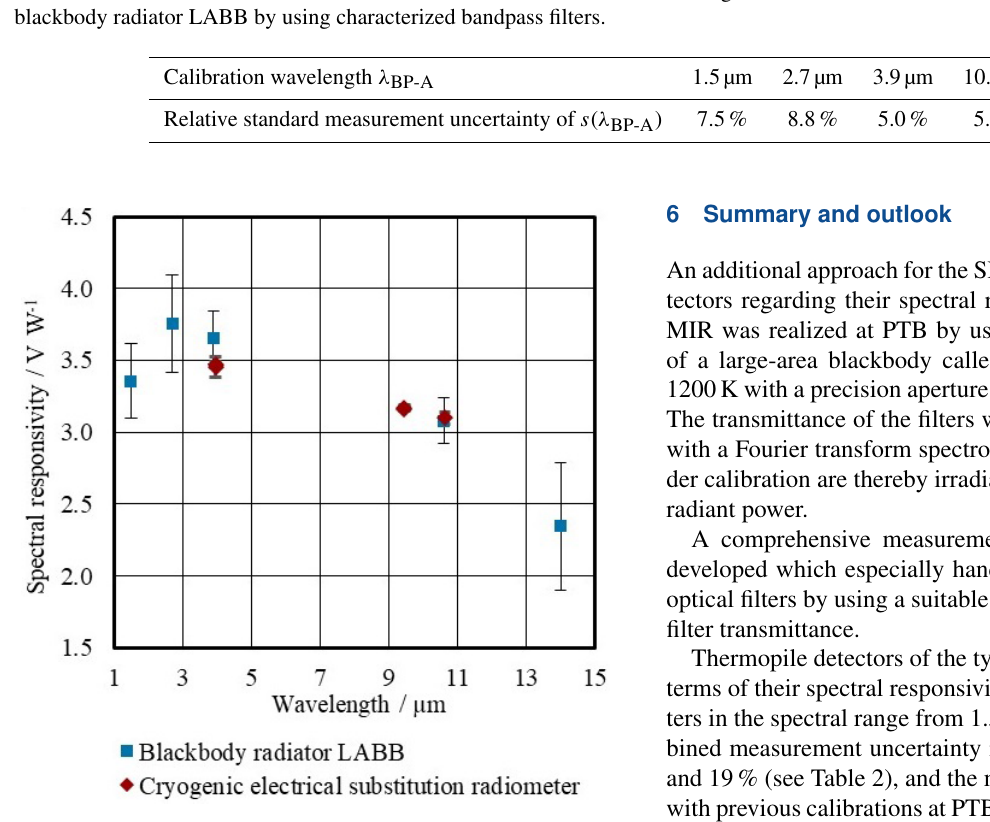
Figure 9. Spectral responsivity of the thermopile detector TS-76 measured with the cryogenic electrical substitution radiometer (red) and at the blackbody radiator LABB (blue). The results are consis- tent within the given combined measurement uncertainty. The un- certainty bars in the diagram represent standard